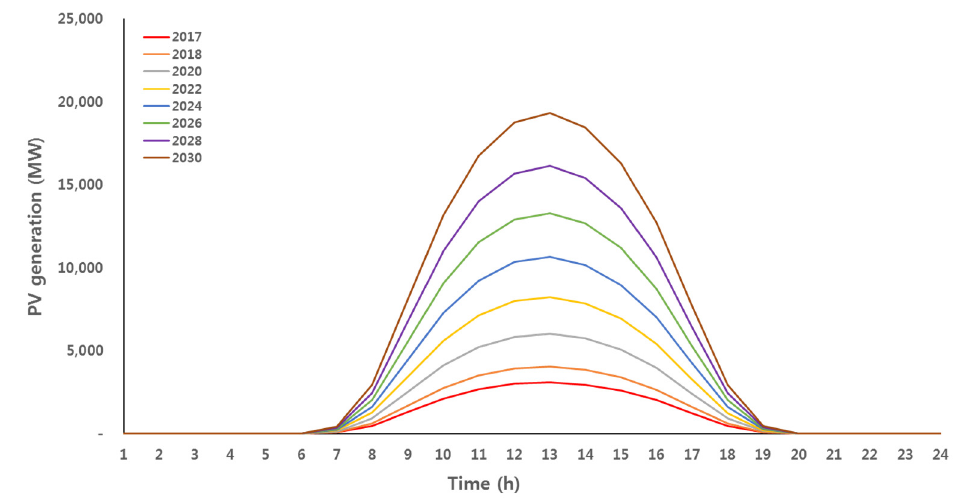
Figure 6. The predicted PV generation curves from 2017 to 2030 in spring and fall.